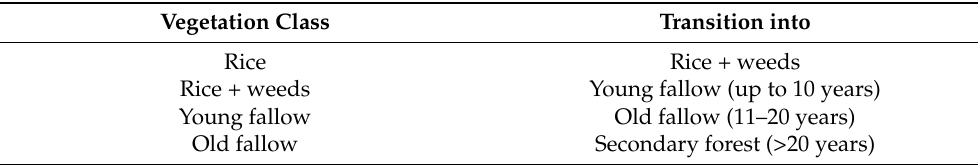
Table 4. Model description: vegetation class transition of landscape